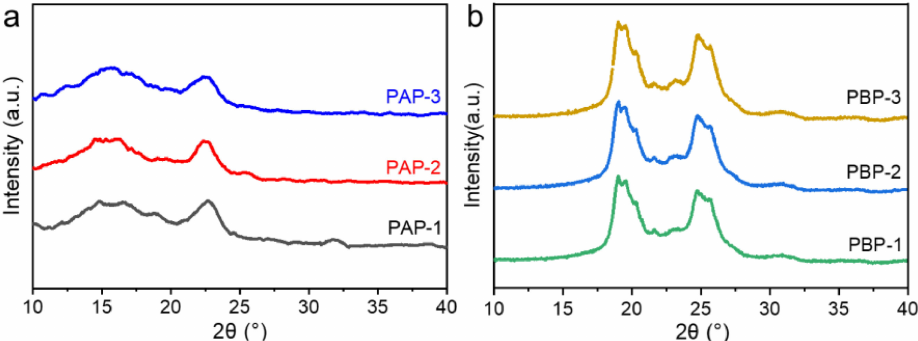
Figure 7. XRD spectra of ( a ) PAP and ( b ) PBP.